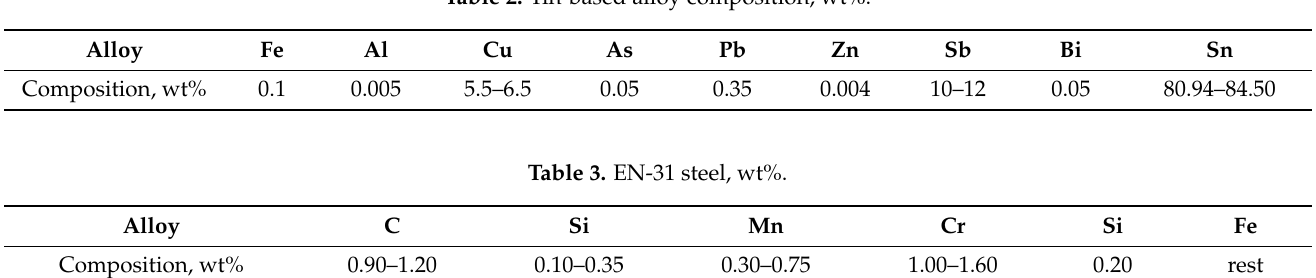
Table 2. Tin-based alloy composition, wt%.